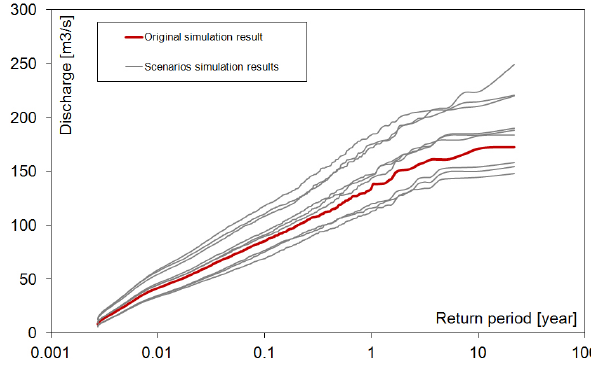
Fig. 17. Changes in empirical peak flow extreme value distribution at BYBLK station after